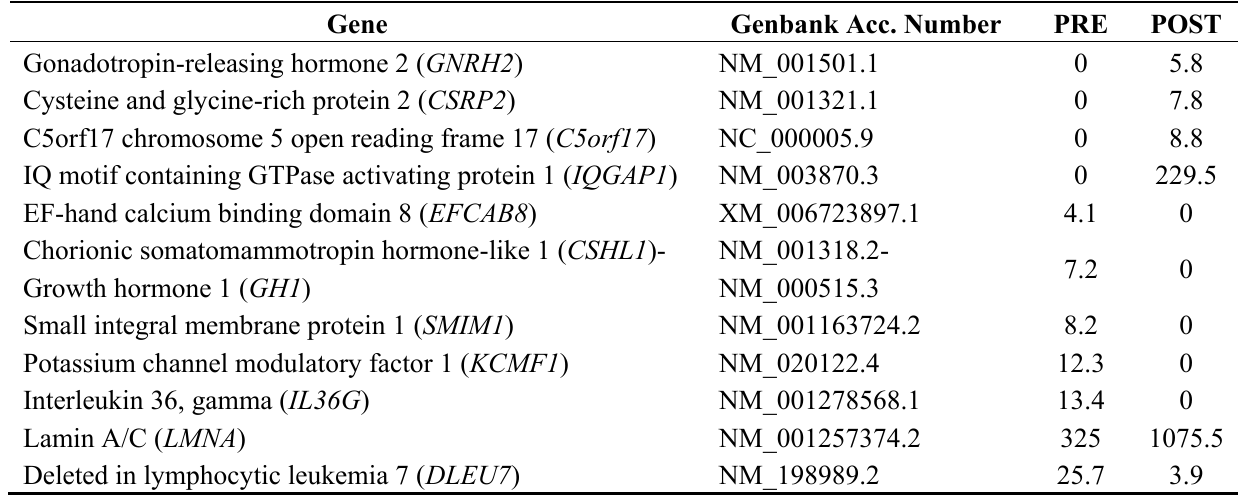
Table 2. Genes whose expression varied ―on-off‖ after oxaliplatin chemotherapy. Relative expression levels, PRE, stands for expression level pre-chemotherapy and POST for post-chemotherapy. LMNA and DLEU7 are genes with polymorphisms sensitive to oxaliplatin that overlap our study. Gene Genbank Acc. Number PRE